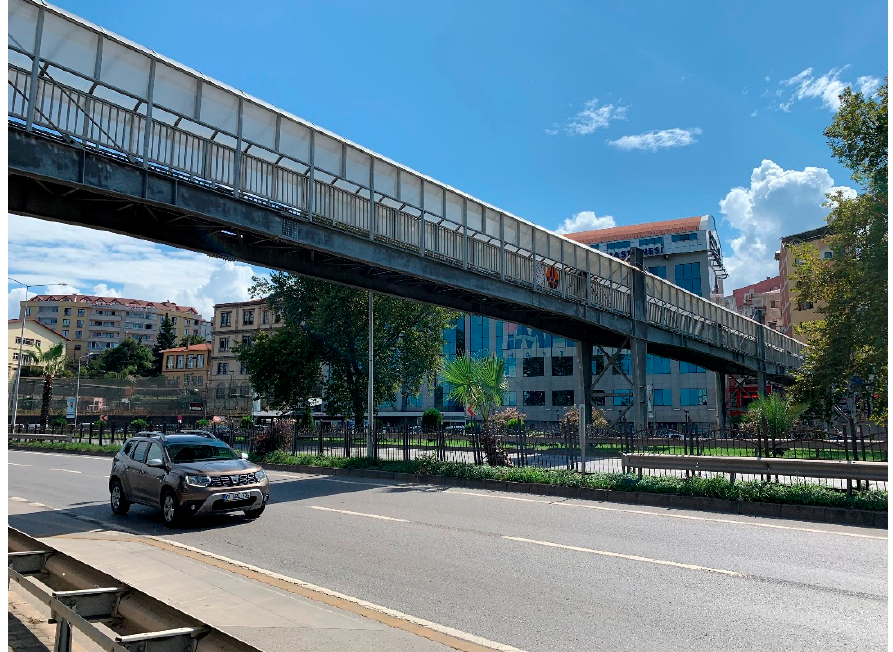
Figure 3. The view of the overpass over the road no. D010, also known as the Black Sea Coastal Highway, after construction of the roofing. Source: own study.